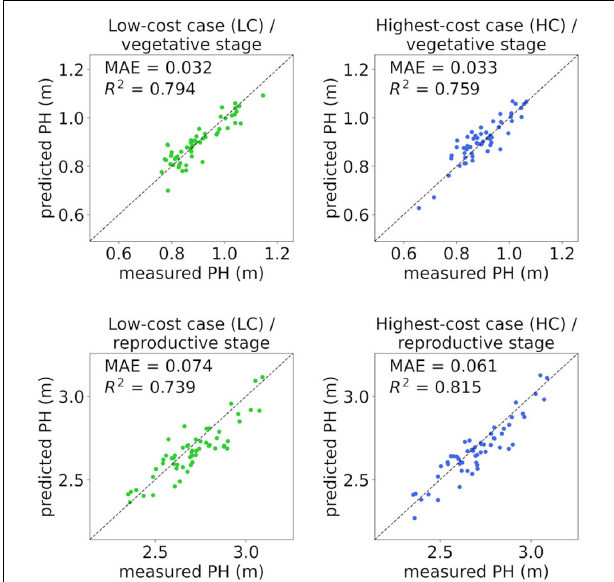
FIGURE 6 | Scatterplots between measured PH ( PH measured ) and PH predicted by the linear regression model from PH SfM on validation data. “Low-cost case (LC)” is the condition with camera angle: − 60 ◦ , RTK: unused [ − ], GCPs: unused [ − ], method: M3; and “Highest-cost case (HC)” is the condition with camera angle: − 60 ◦ , RTK: used [ + ], GCPs: used [ + ], method: M1. In each set of analysis conditions (LC or HC) and stage (vegetative or reproductive), the nearest to the mean in R 2 val was selected from 18 validation cases.